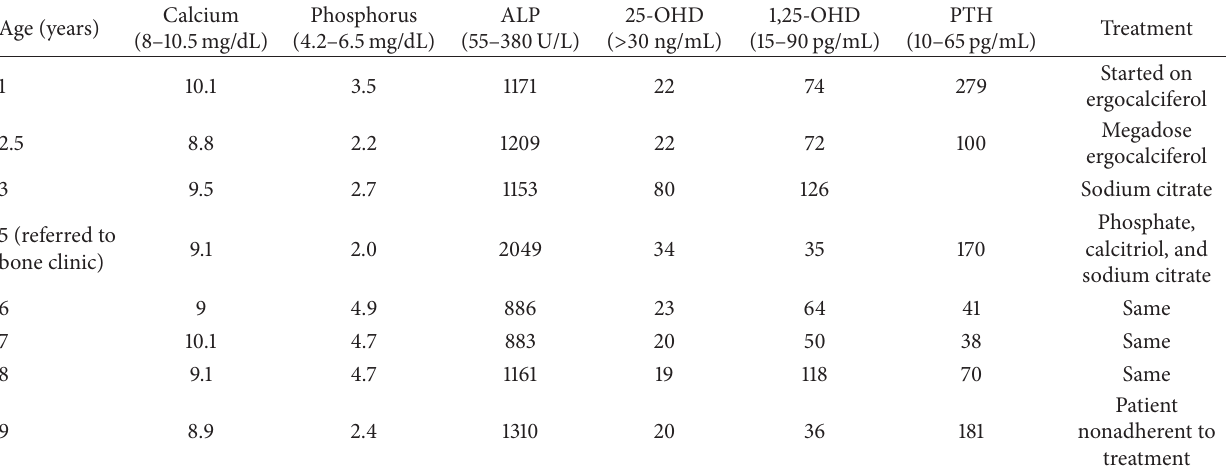
Table 1: Biochemical data over the course of